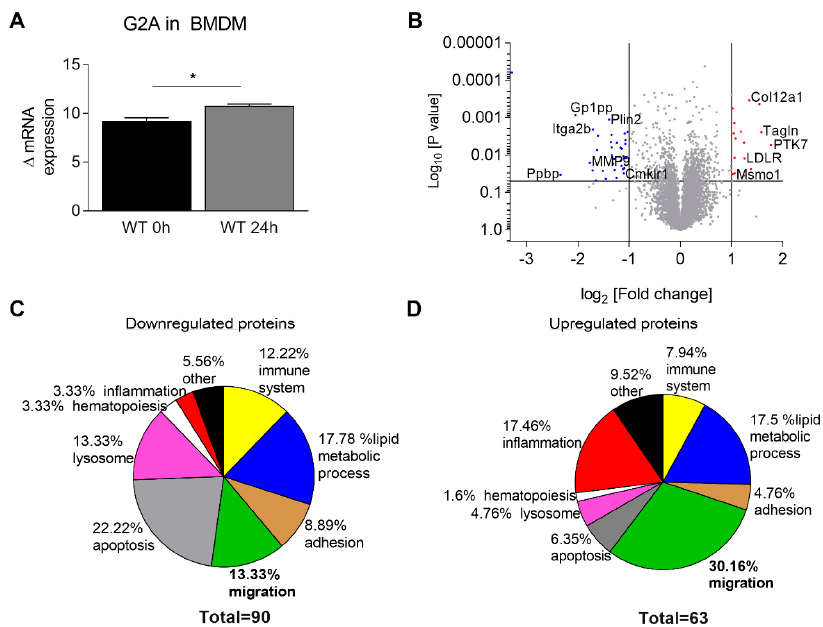
Figure 4. Protein regulation in wild-type bone marrow-derived macrophages (BMDMs) 24 h after stimulation with 9-HODE. ( A ) Relative mRNA expression of G2A receptor in BMDMs treated with 1 µM 9-HODE for 24 h. n = 6–10 animals per group, male. ( B ) Identification of >6.000 regulated proteins 24 h after stimulation with 1 µM 9-HODE in BMDMs. Fold change (FC) [log2] is plotted against p - values [Log10]. Significant downregulated proteins are depicted in blue, and red represents upregulated proteins. ( C ) Percentage of downregulated proteins 24 h after 1 µM 9-HODE stimulation compared to untreated BMDMs. ( D ) Percentage of upregulated proteins 24 h after 1 µM 9-HODE stimulation compared to untreated BMDMs, clustered in groups. yellow: immune system, blue: lipid metabolic process, brown: adhesion, green: migration, grey: apoptosis, pink: lysosome, red: inflammation, white: hematopoiesis, black: other. Data represents mean ± SEM. * p < 0.05. An unpaired one-tailed t-test was used for statistics.